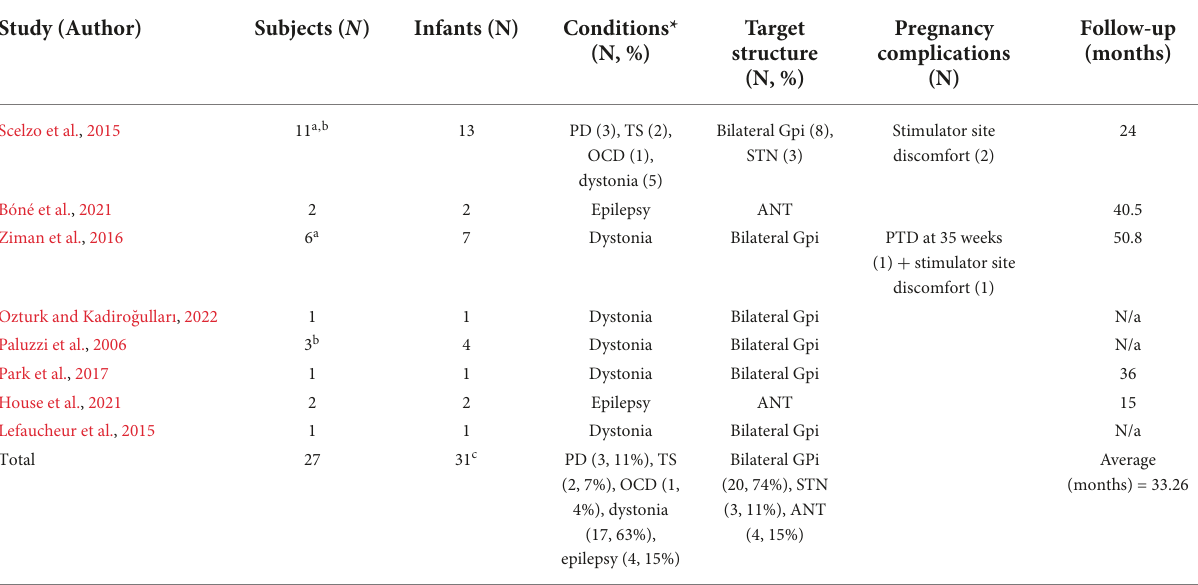
TABLE 1 Deep brain stimulation (DBS) literature review